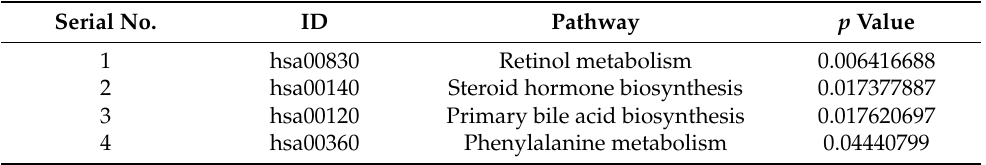
Table 3. Pathways enriched between NPEC versus NNAE using pathview.